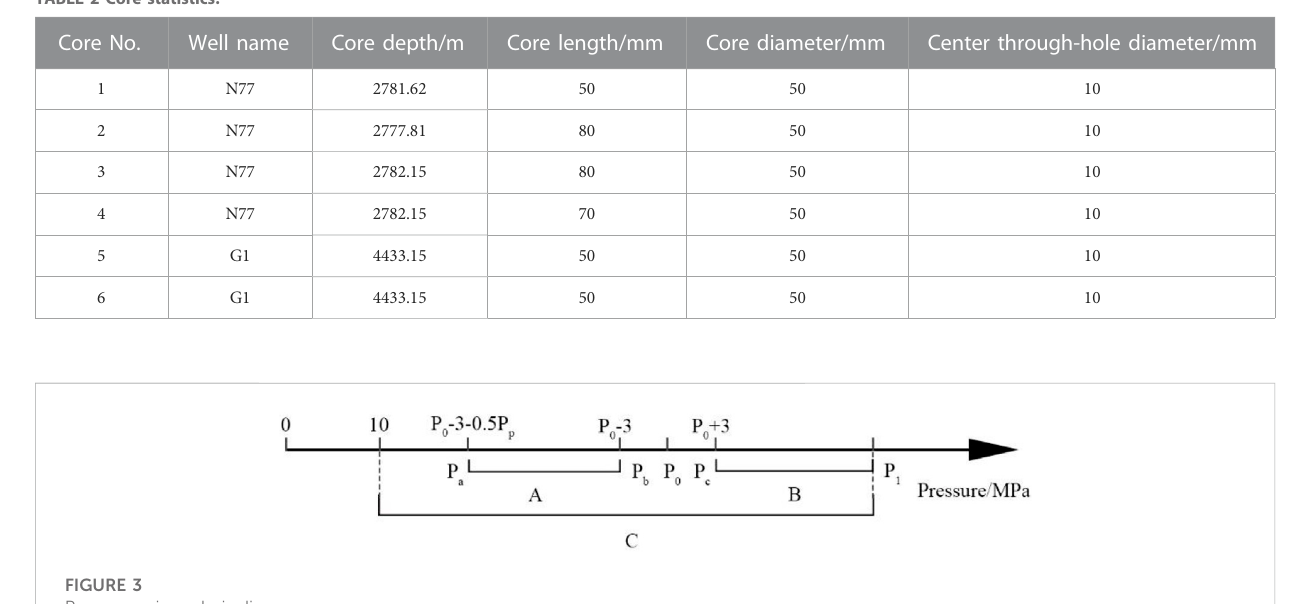
TABLE 2 Core statistics.